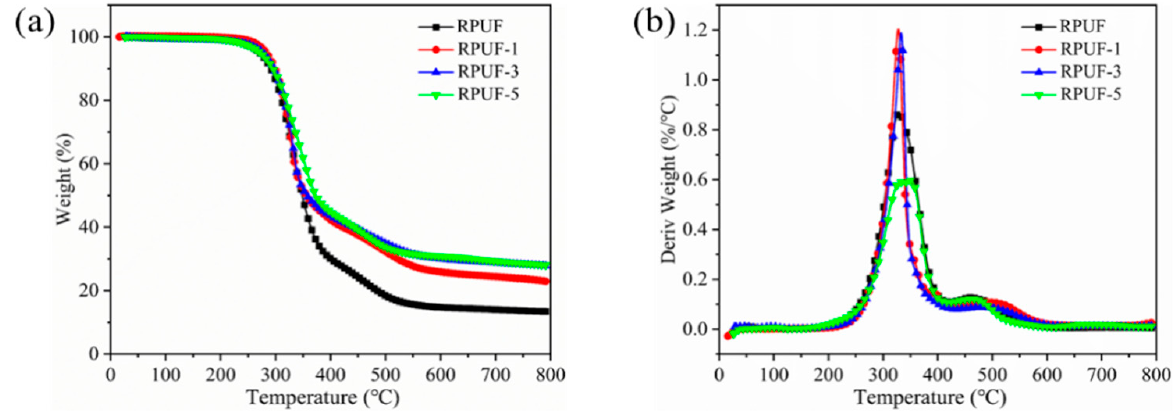
Figure 2. ( a ) thermogravimetric (TG) and ( b ) thermal weight loss (DTG) curves of RPUF and RPUF-R composites. Table 3. Thermogravimetric data of RPUF and RPUF-R composites (nitrogen atmosphere).